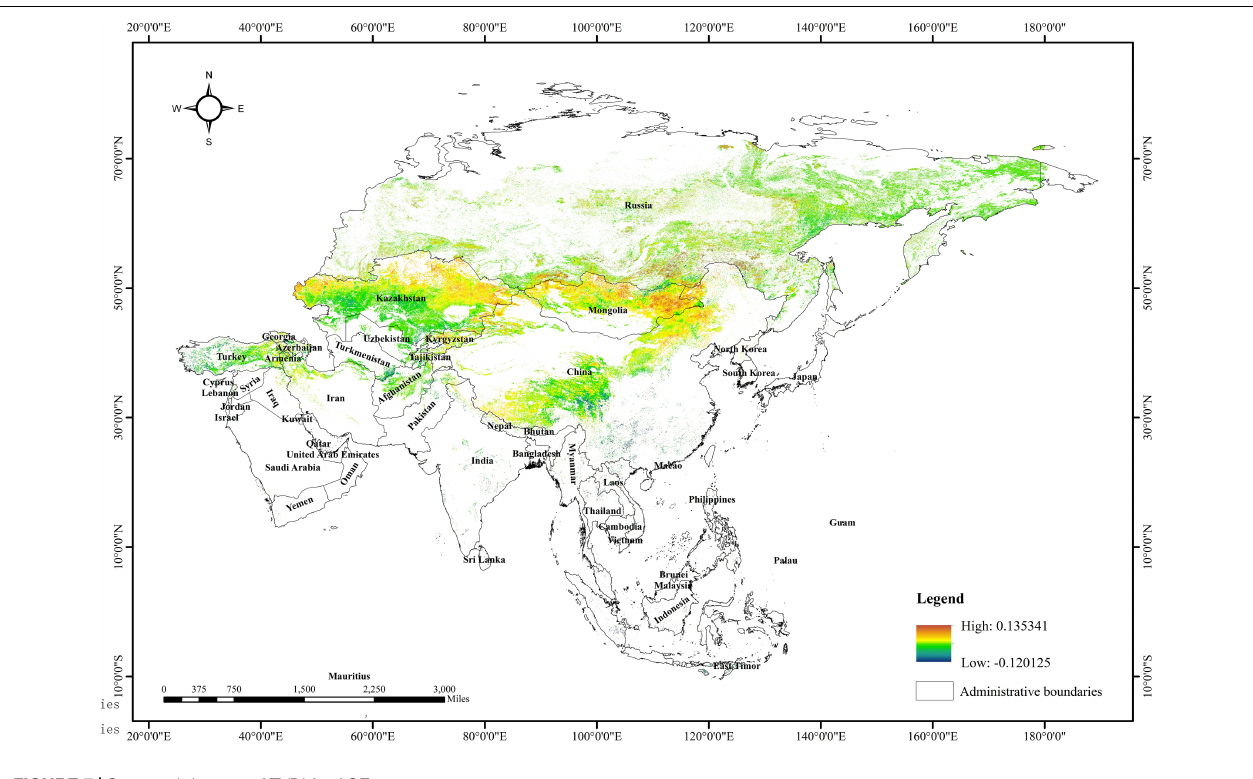
FIGURE 7 | Sen trend degrees of TVDI for